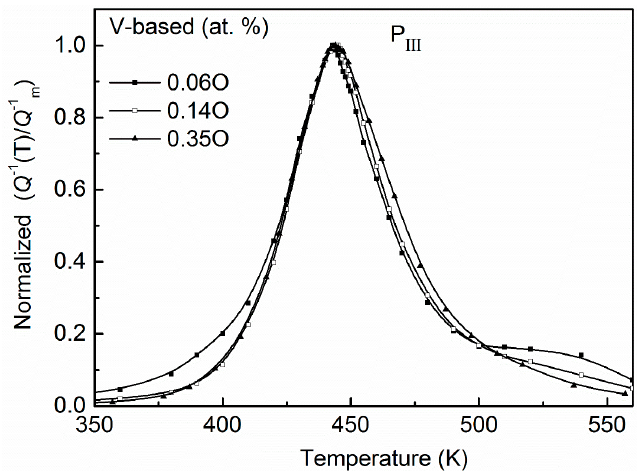
Figure 2. Normalized relaxation peaks for Nb–99.5V alloys with 0.06, 0.14, and 0.35 at. % O. No significant broadening effects appear with increasing of oxygen concentration.